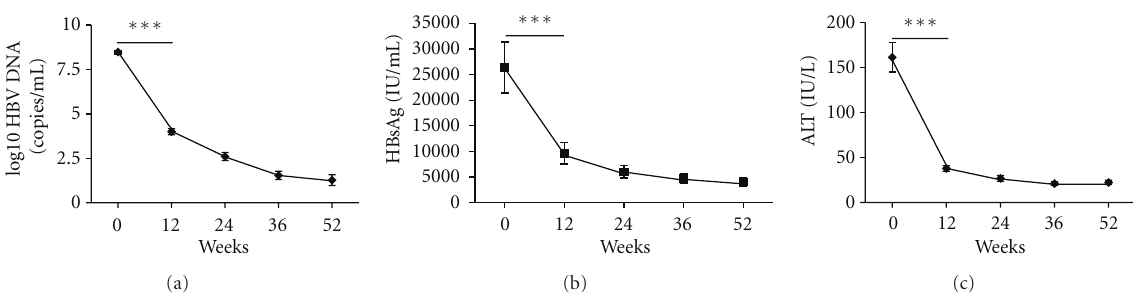
Figure 1: Clinical characteristics of CHB patients after treatment with telbivudine. Serum samples were collected from 38 CHB patients treated with telbivudine at five time points after treatment initiation. HBV DNA level was detected by qPCR. Serum HBsAg concentration was detected by ELISA. Serum ALT was measured by the CHEMIX-180 automated biochemistry analyzer (Japanese SYSMEX Corporation). ∗∗∗ P < 0 . 001 versus baseline